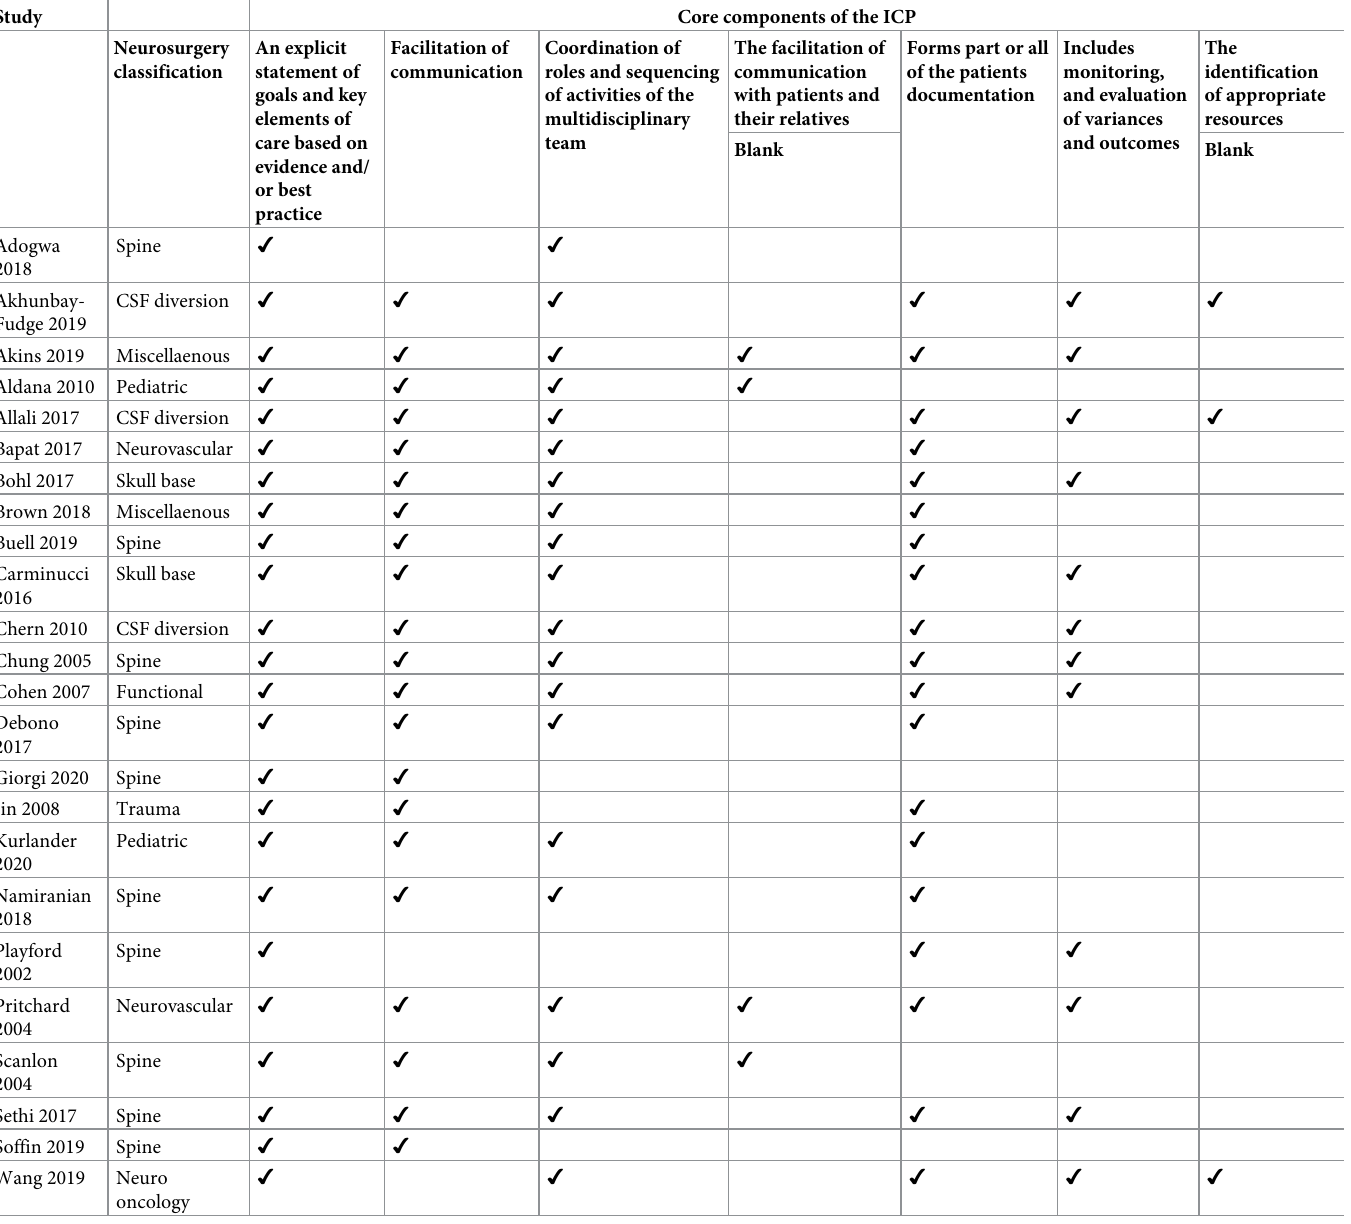
Table 2. Included studies fit with the core components of the EPA definition of an